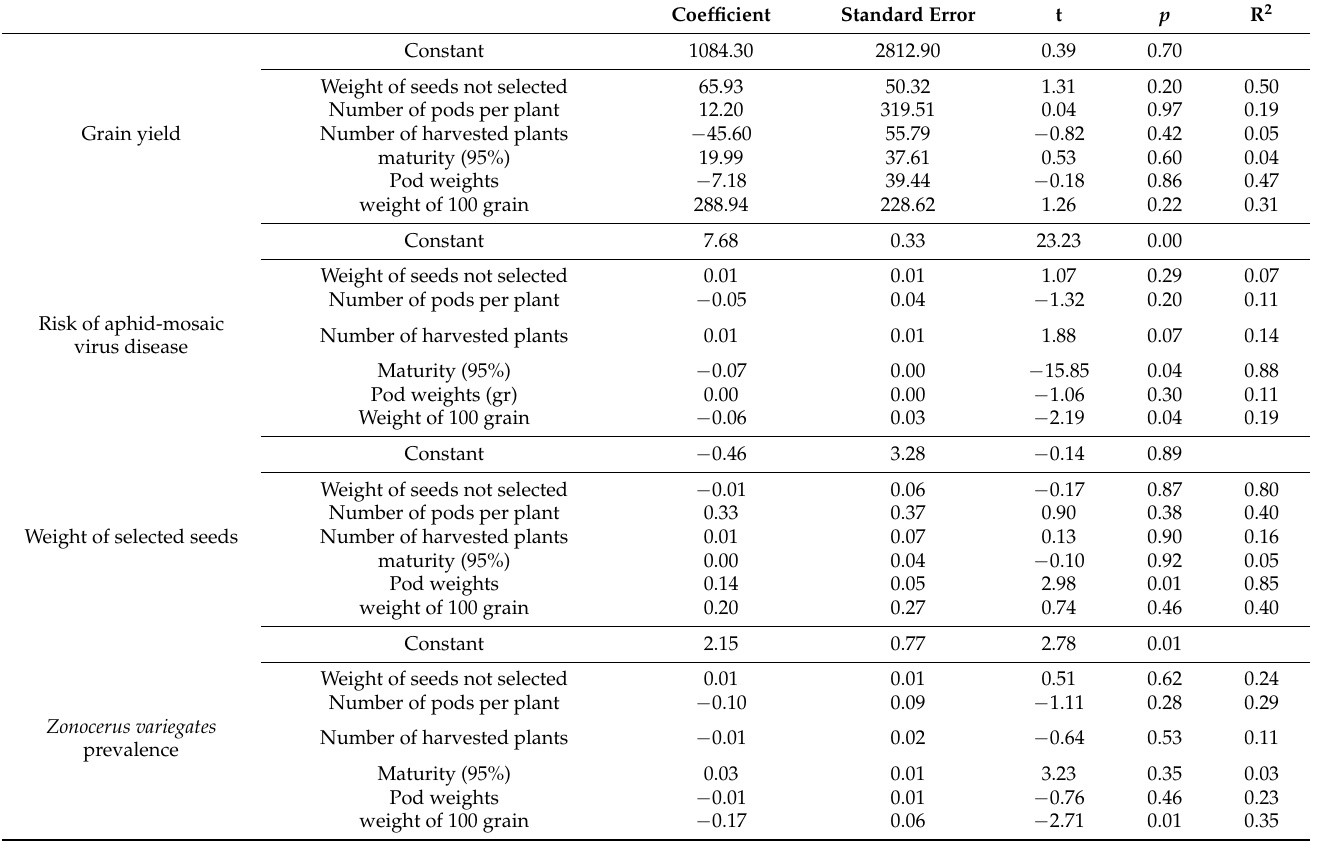
Table 6. Multiply regression for crop parameters defined by four environmental